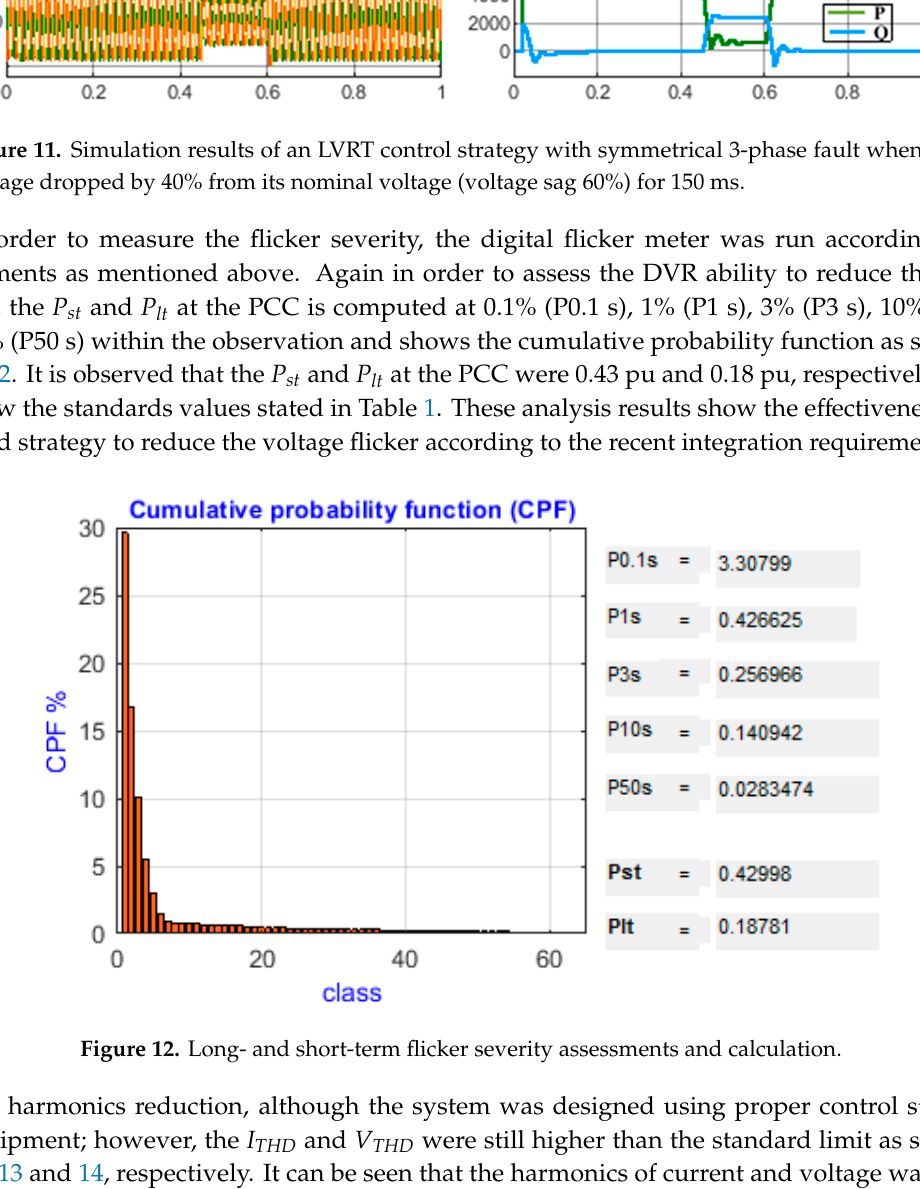
Figure 13. Total and individual harmonics levels of the output voltage at the point of common coupling (PCC).